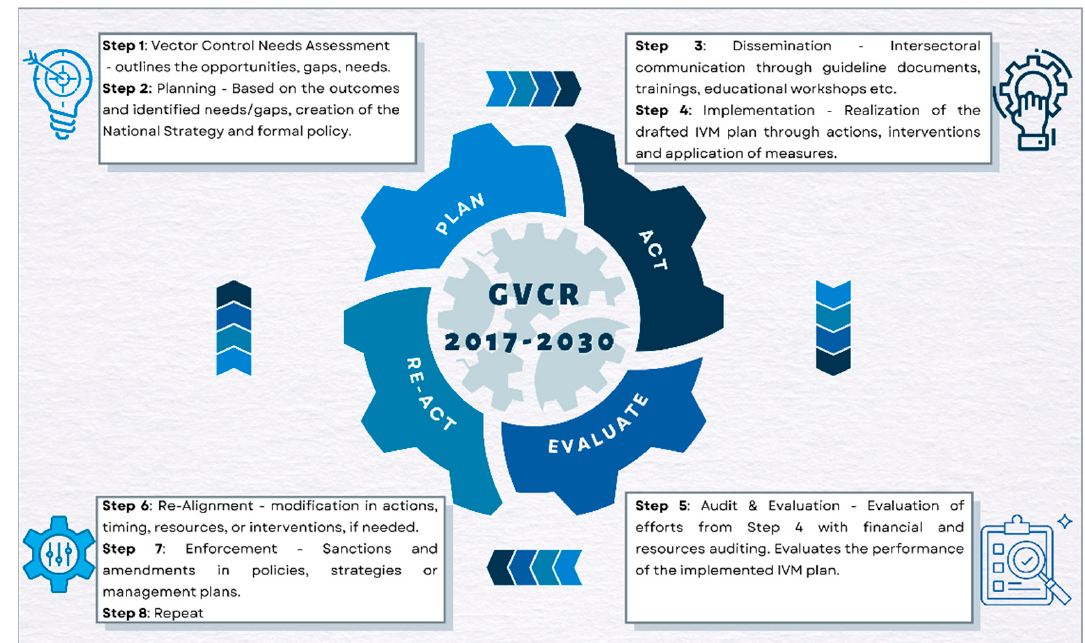
Figure 1. The Circular Policy approach.